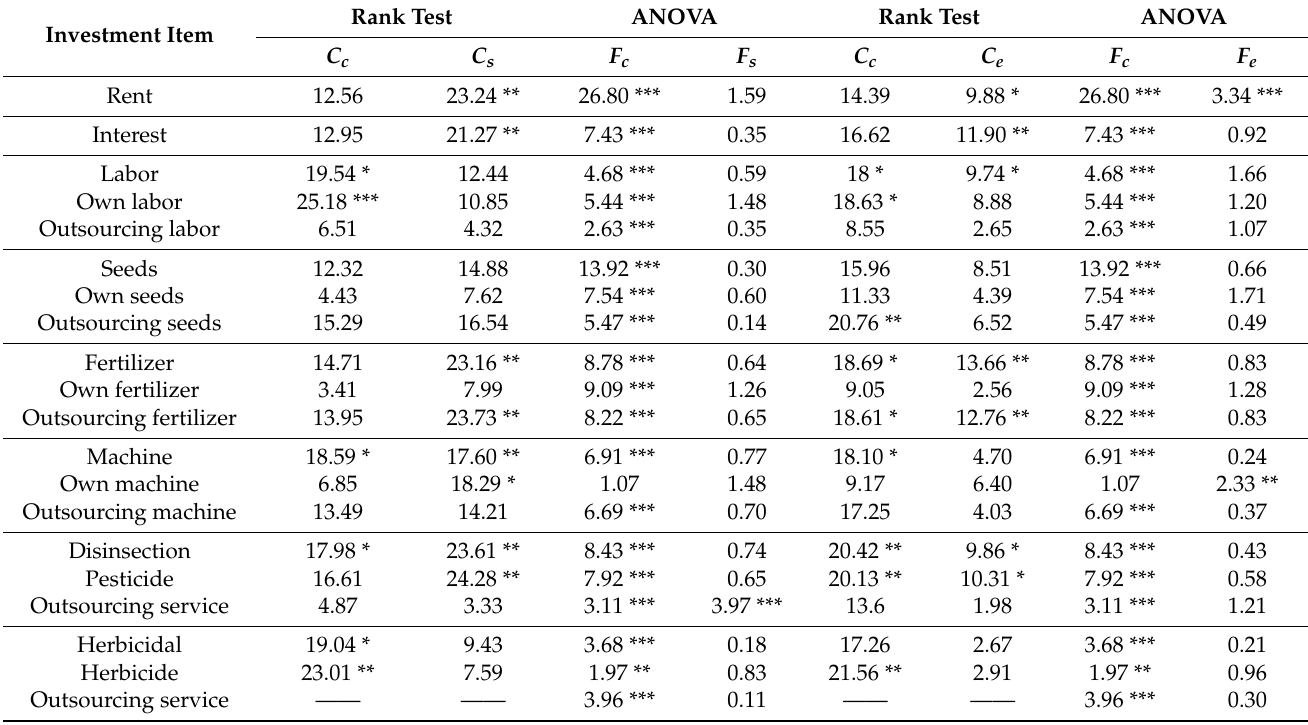
Table 5. Transaction Costs versus Subtraction and Farming Experience efficiency comparisons using two-factor rank test and